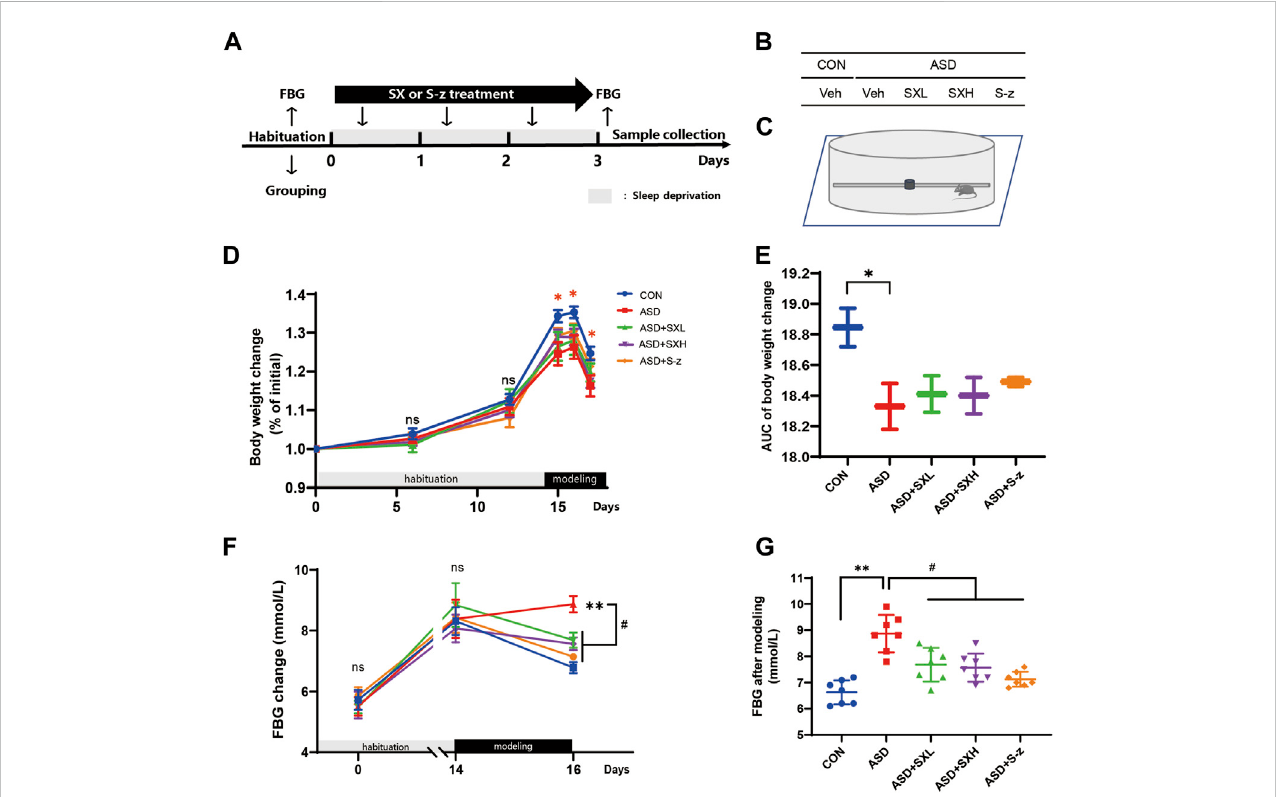
FIGURE 1 SX alleviates ASD-induced clinical symptoms associated with gastrointestinal dysfunction in mice. (A) Schematic representation of the experimental design. After 14 days of habituation, mice were sleep deprived for 3 days and orally administered with distilled water, SX, or S-z, once a day. Fasting blood glucose levels, body weight, and food and water consumption wererecordedat all points. (B) Grouping of mice. CON = control; ASD = acute sleep deprived; Veh=vehicle;SXL=low-doseSX;SXH=high-doseSX;S-z=S-zopiclone. (C) Schematicdiagramshowsacutesleepdeprivationmodeling.SXalleviates ASD-induced weight loss. (D, E) Body weights of the CON, ASD, ASD + SXL, ASD + SXH, and ASD + S-z group mice during habituation and ASD modeling. p < 0.05, CON vs. ASD; (F, G) Fasting blood glucose levels of the CON, ASD, ASD + SXL, ASD + SXH, and ASD + S-z group mice during habituation and ASD modeling. p < 0.05,ASDvs.SXL,SXHandS-z.Datawereexpressedasmeans±SEM. n =7pergroup.Two-wayANOVAforDandF;one-wayANOVAforEand G; * p < 0.05, ** p < 0.01 vs. control group; # p < 0.05 vs. ASD group; ns, no signi fi